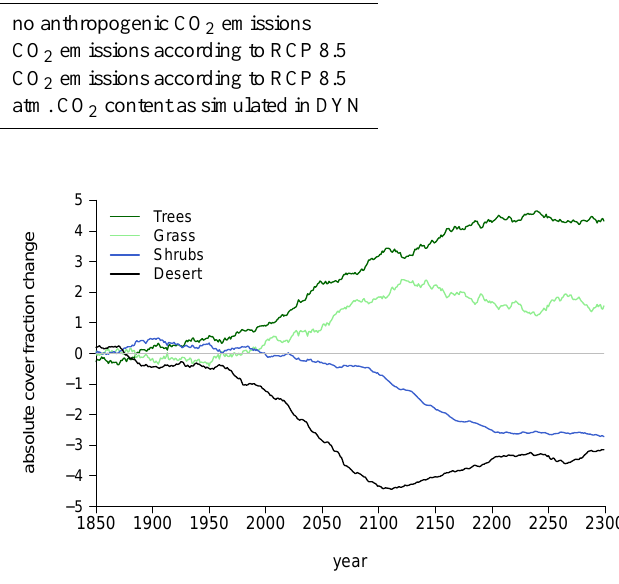
Fig. 3. Time series of changes in absolute global mean vegetation cover (DYN – CTL) in [%]. Forest includes tropical evergreen and deciduous trees as well as extra-tropical evergreen and deciduous trees. Shrubs contain cold and rain green shrubs and grass includes C3 and C4